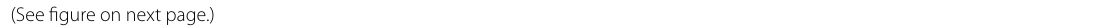
Fig. 3 The mast cell and macrophage are not targets for famotidine. A – F Mast cell deficient Kit W−sh /Kit W−sh sash mice had similar LPS-induced TNF, IL-6, IL-1β response as wild type mice. Male wild type (WT) or “sash” mice received LPS injection (IP, 7 mg/kg) and were euthanized 2.5 h post-LPS injection. Serum and spleen TNF, IL-6 and IL-1β were measured. N 3. G – J Famotidine, administered ICV, reduced LPS-induced TNF and IL-6 release = in mast cell deficient Kit W−sh /Kit W−sh sash mice at 2.5 h post LPS exposure. Male Kit W−sh /Kit W−sh sash mice received famotidine or PBS (0.4 mg/kg, in 5 µl volume) administered ICV at 30 min prior to LPS injection (IP, 7 mg/kg). Mice were euthanized 2.5 h post-LPS injection and serum TNF and IL-6 were measured. N 3 for normal wild type, n 4 for normal “sash”, 5 for LPS, 5 or 7 for LPS famotidine group. *P < 0.001. **P < 0.0001. K – N RAW = = + 264.7 cells (K-L) or thioglycollate-elicited mouse primary peritoneal macrophages (M–N) in 96-well culture plates were stimulated with LPS (0.4 ng/ ml) in combination with various amounts of famotidine for 16 h. TNF (K,M) and IL-6 (L,N) released in the supernatants were measured. n 3–6 per = treatment. *P < 0.05 vs.